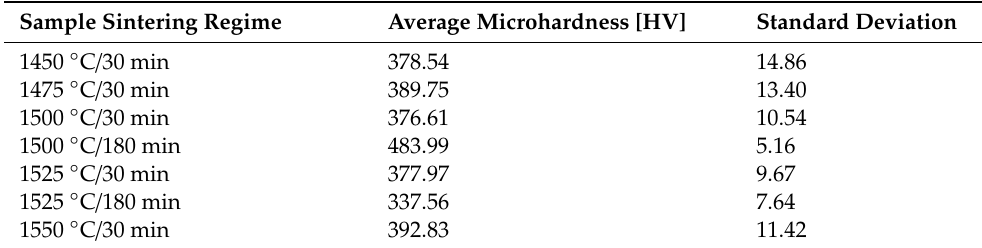
Table 1. Average microhardness for sintered pieces.